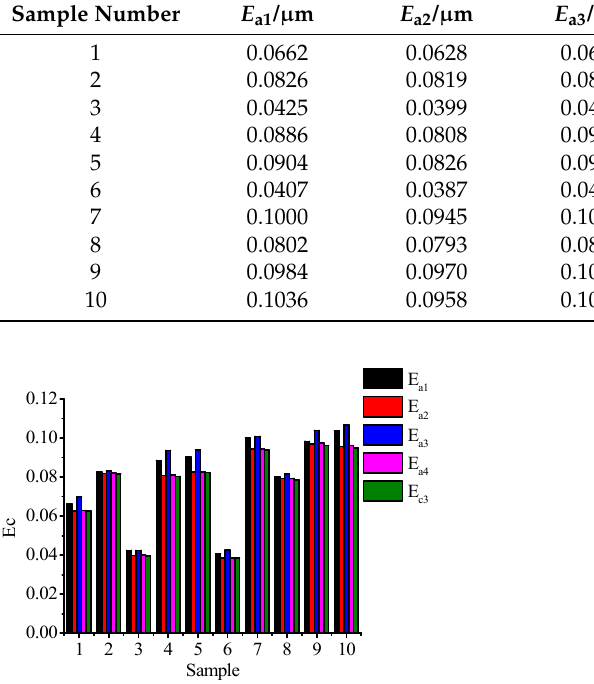
Table 4. Roundness error calculation results of different methods.